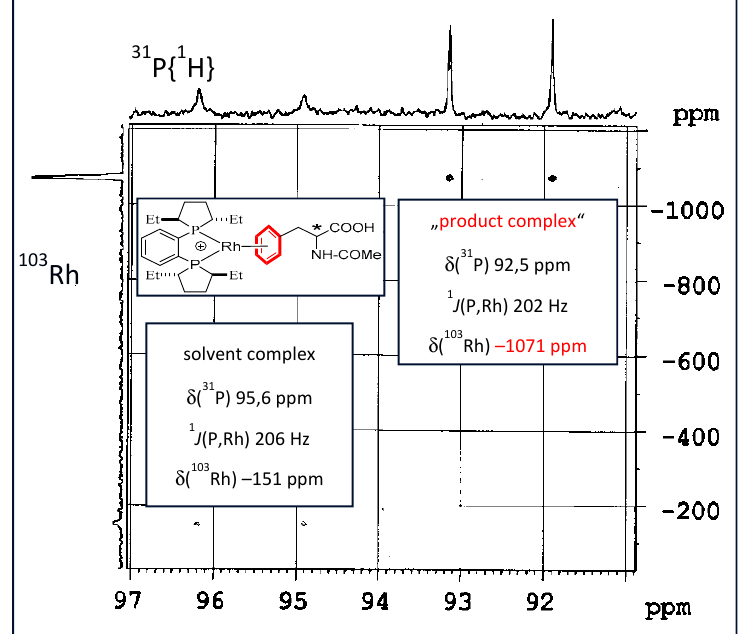
Figure 14. 31 P{ 1 H}- 103 Rh HMQC spectrum of the rhodium- α -acetamidocinnamic acid (H) 2 adduct [Rh(Et-DuPhos)( η 6 - α -acetamidocinnamic acid (H) 2 )] + , in MeOH- d 4 , its signals are clearly distinguishable from those of the solvent complex [Rh(Et-DuPhos)(solvent) 2 ] + .